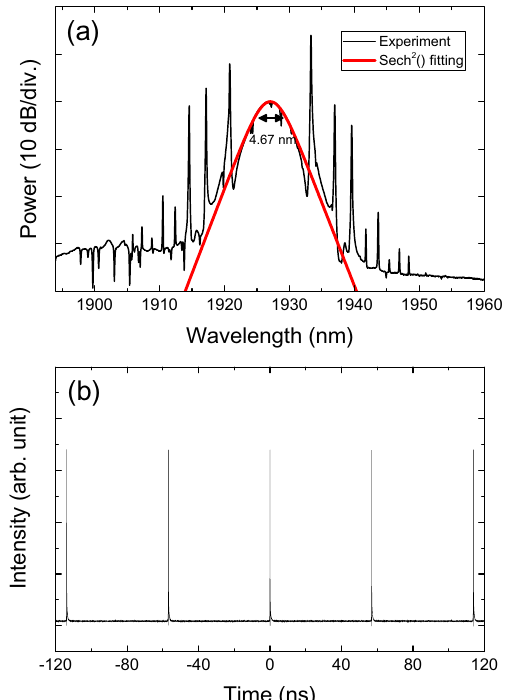
Figure 9. ( a ) An optical spectrum and ( b ) an oscilloscope trace of the output pulses at a pump power of ~ 297